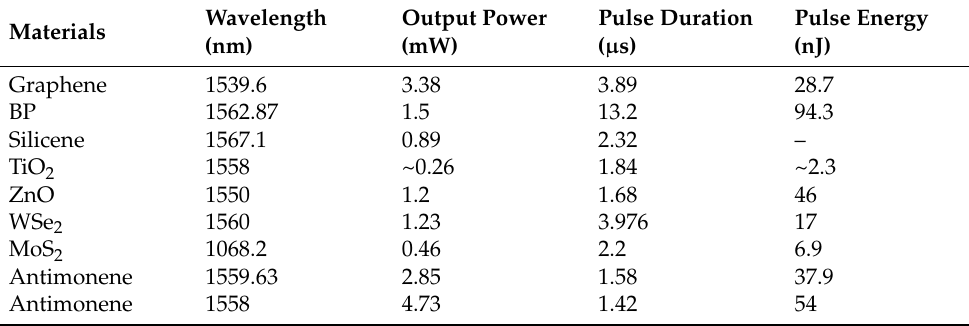
Table 2. Comparison of applied power and pulse time of various materials in laser [27].